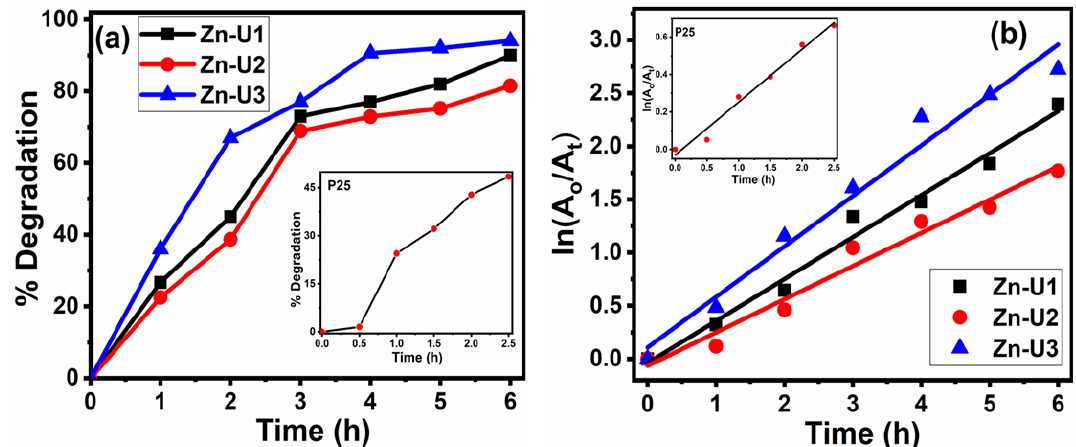
Figure 9. ( a ) MB dye degradation rate ( b ) the logarithmic change in concentration of MB as a function of irradiation time with insets of P25.